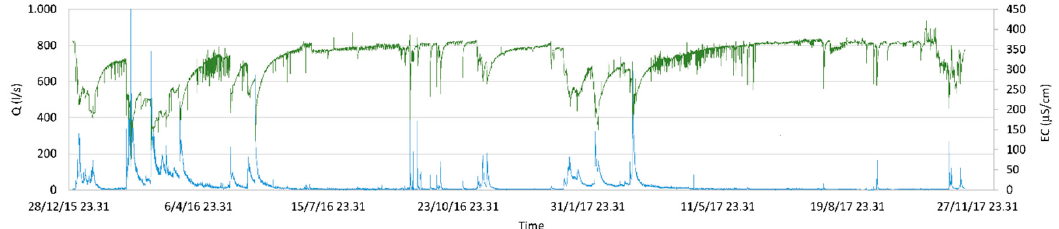
Figure 4. High-frequency (5 min) discharge (Q)—electrical conductivity (EC) dataset, collected at the outlet catchment (blue line: Q; green line: EC).